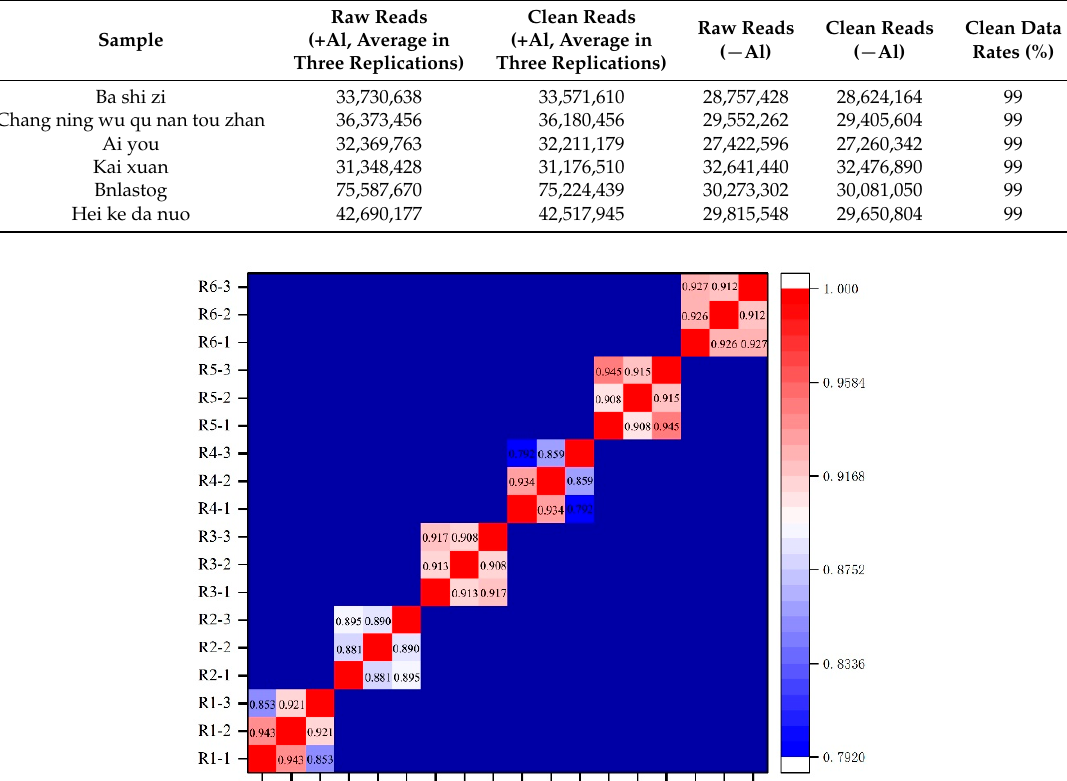
Figure 2. The correlation coefficients among the three biological replications. R1, R2, R3, R4, R5, and R6 represent Ba shi zi, Chang ning wu qu nan tou zhan, Ai you, Kai xuan, Bnlastog and Hei ke da nuo, respectively.